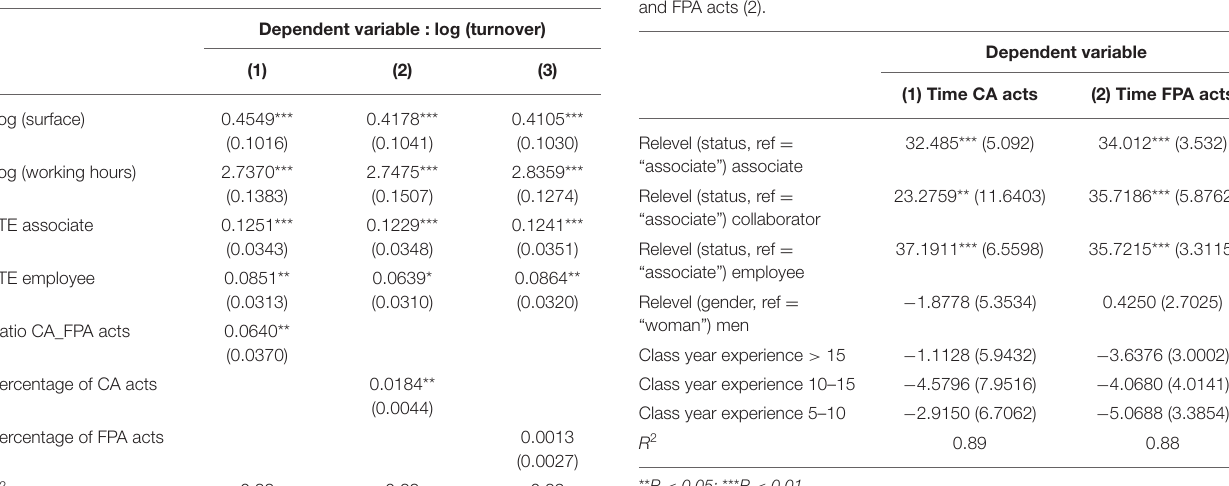
TABLE 6 | Results of regression models of the association between the variables characteristic of veterinary practices and the turnover.